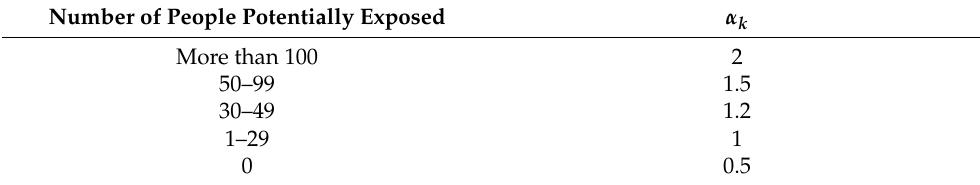
Table A1. Table of Correction factor value α k for exposed persons.